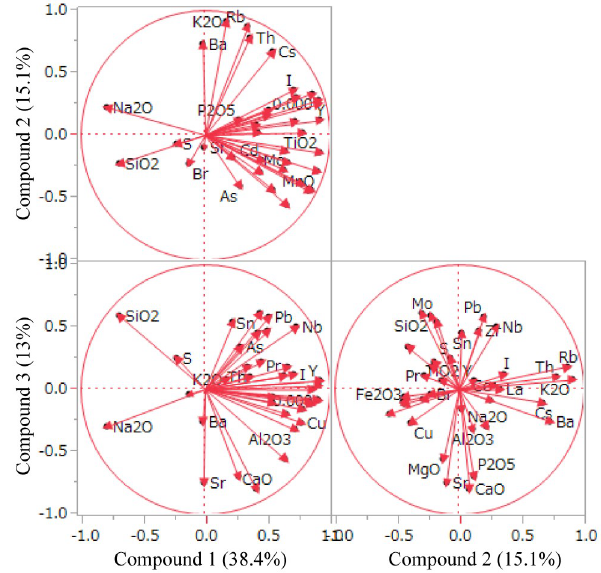
Fig. 9. Comparative diagram of the main three compounds described in the Shuteen soil geochemistry. Scatters of the representative elements contained in the soil of each Compound. Confidence coefficients: Compound 1- 38.4%, Compound 2 - 15.1%, Compound 3 -